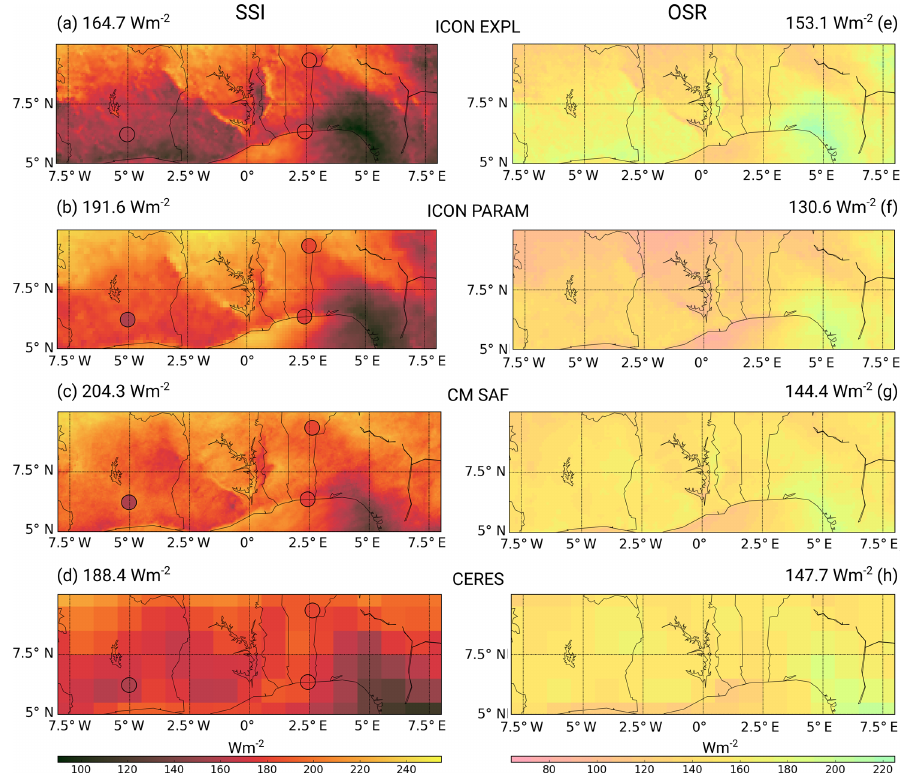
Figure 3. Mean July 2006 SSI over the DACCIWA box from (a) ICON EXPL and (b) ICON PARAM as well as the satellite-derived datasets (c) CM SAF and (d) CERES plus station data as filled circles. Corresponding OSR fields are given in (e) – (h) . Area averages are provided on top of each